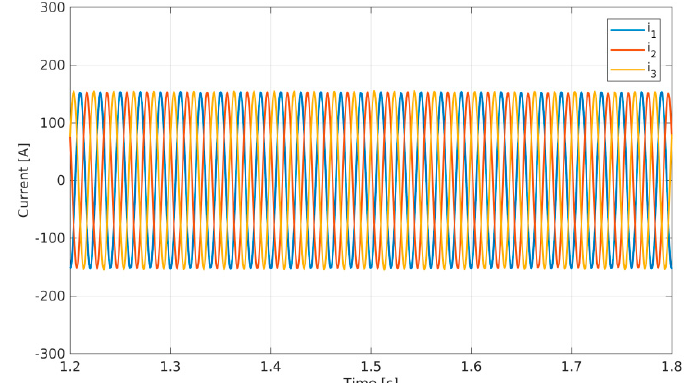
Figure 14. Voltage in the DC sides of the two inverters with a voltage sag of 70% and with the increase in the voltage of the floating capacitor.